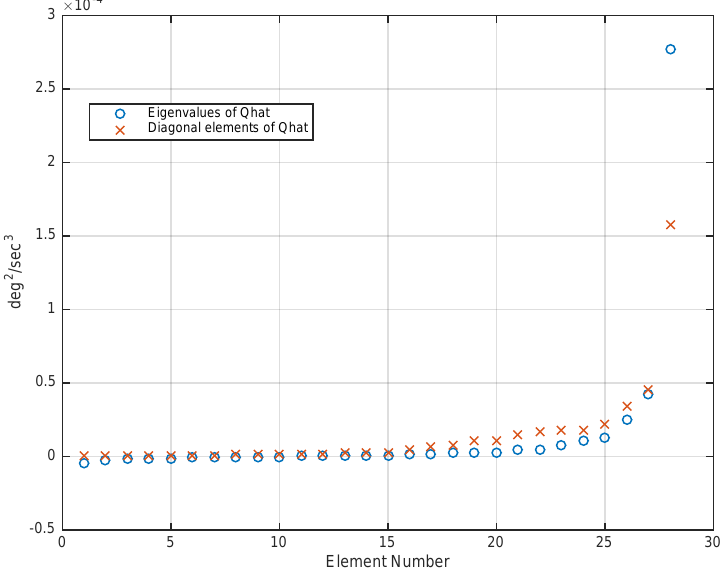
Figure 2. Sorted eigenvalues and sorted diagonal elements of the matrix ˆ Q , which was estimated from data from a 28-gyro